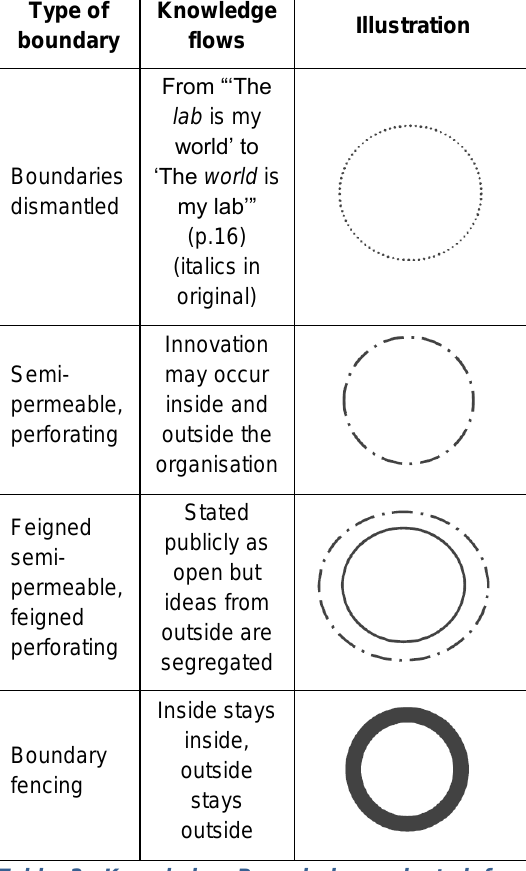
Table 3: Knowledge Boundaries- adapted from Lifshitz-Assaf (2017, p.15) Part 2: